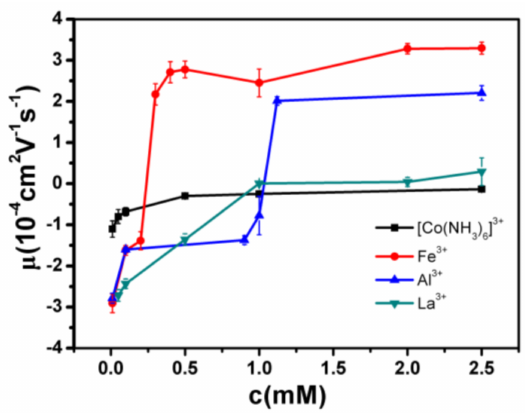
Figure 2. Electrophoretic mobility of DNA as a function of the concentration of different trivalent metal ions.